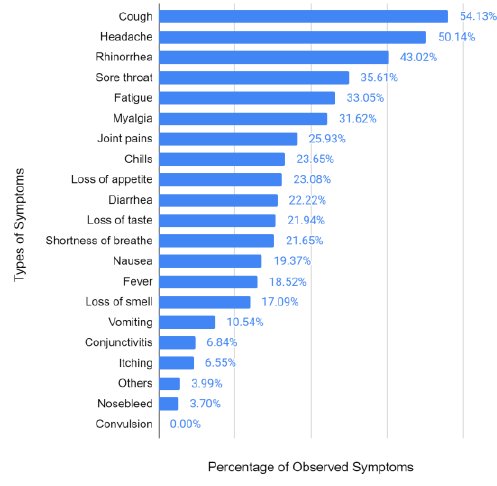
Figure 1. Frequency of symptoms in participants.